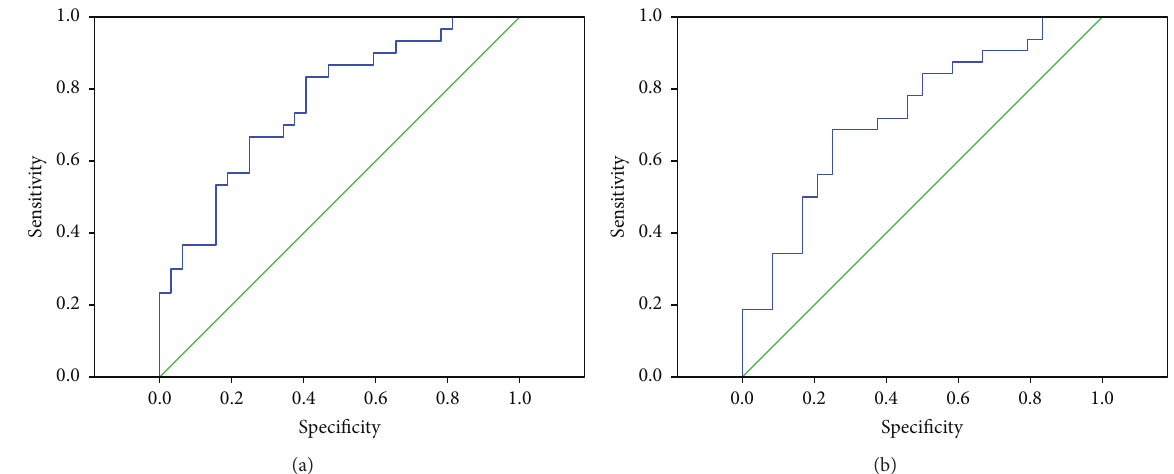
Figure 3: ROC curve analyses for IPF patients according to the plasma levels of leptin. ((a)-(b)) The areas under ROC curves of leptin were statistically significant in the classification of AE-IPF subjects ( 𝑛 = 30 ) or S-IPF patients ( 𝑛 = 32 ) and the decedent ( 𝑛 = 33 ) or the survivor ( 𝑛 = 23 ) ( 𝑝 < 0.001 , cut-off value 15.52 ng/mL and 𝑝 = 0.004 , cut-off value 13.79 ng/mL, resp.).